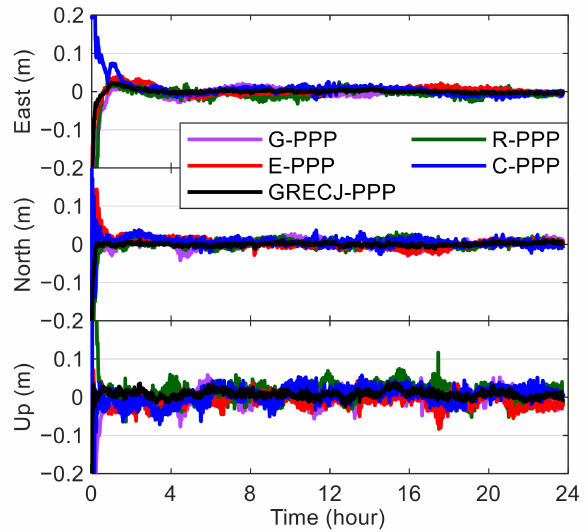
Figure 12. Epoch-wise position errors of kinematic PPP using ESA final precise products at station